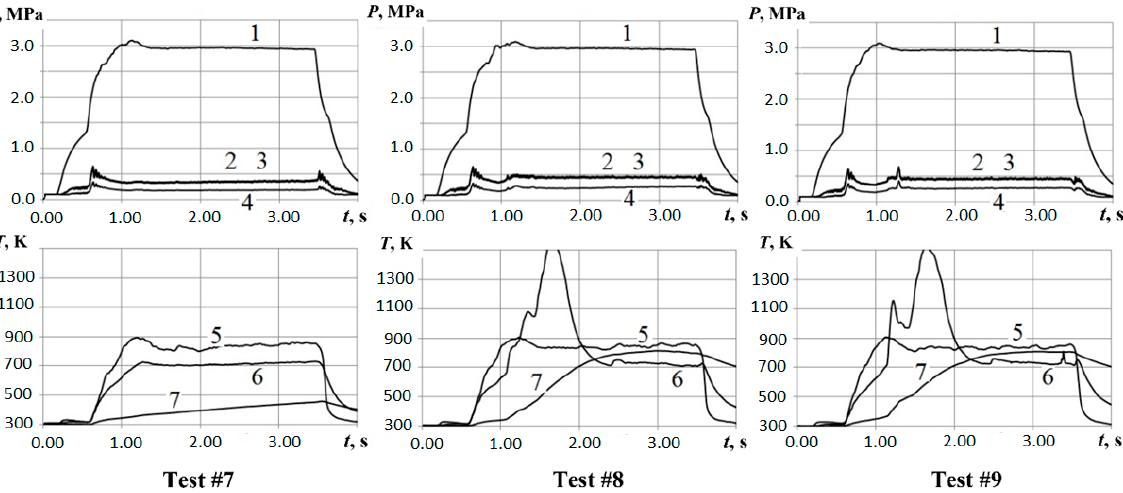
Figure 6. Test results at M 1 = 3.81 (see Table 1): 1— Р 0 ; 2— P 0,in ; 3— P 0,out ; 4— P out ; 5— T 0 ; 6— T 0,in ; 7— T 0,out.